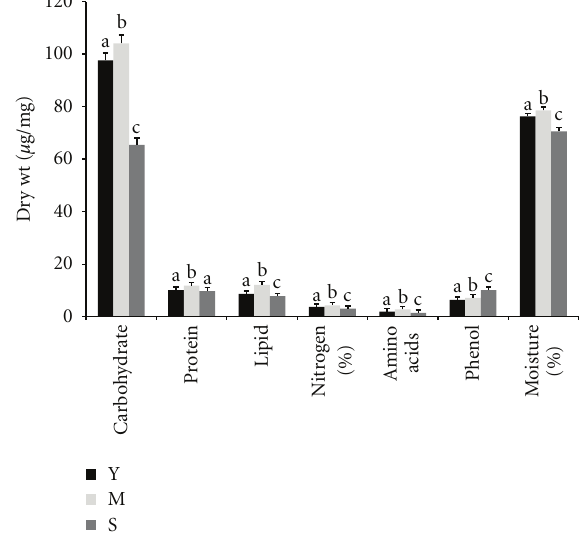
Figure 4: Biochemical compositions of young (Y), mature (M), and senescent (S) sunflower leaves. Means ± SE of five observations. The di ff erent letters over the three bars indicate that the means are significantly di ff erent at P < 0 .